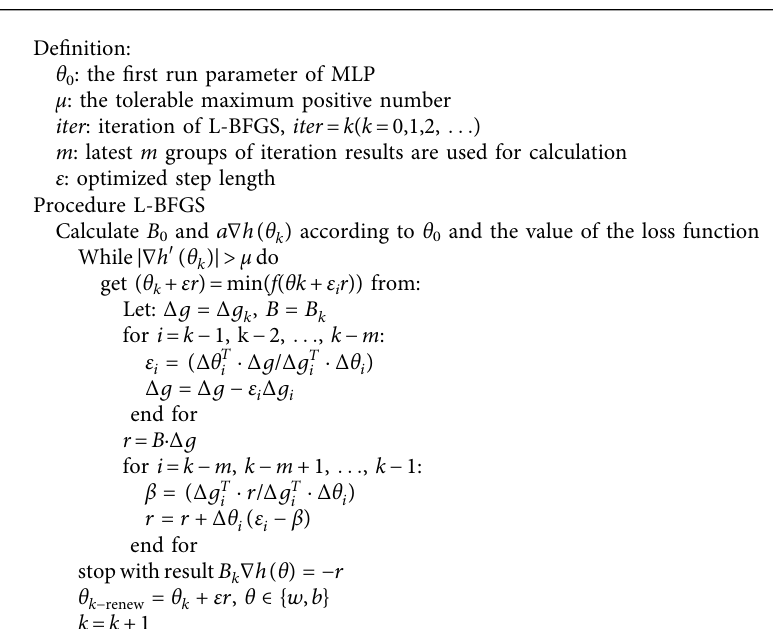
Figure 2: Working principle of